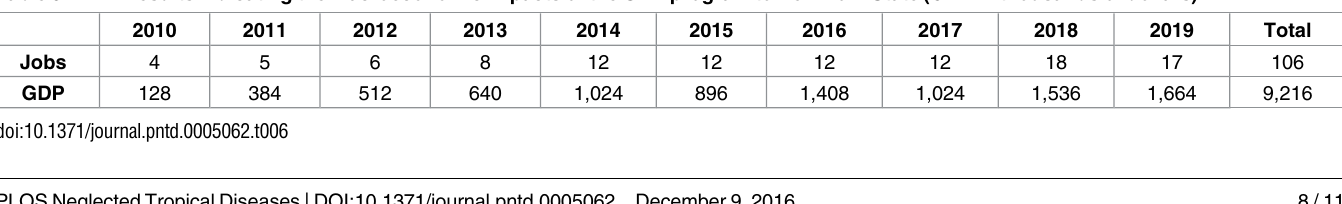
20% more PEP and AT